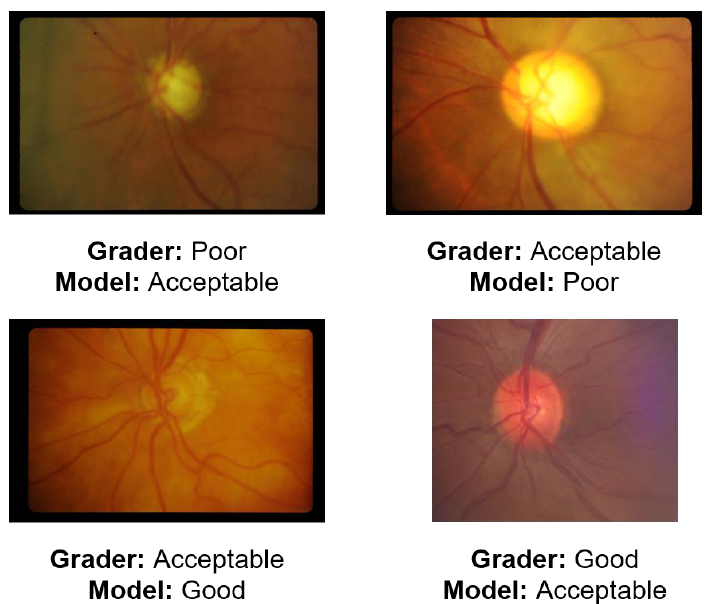
Figure 3. Representative sample of images mispredicted by the ternary classification model.